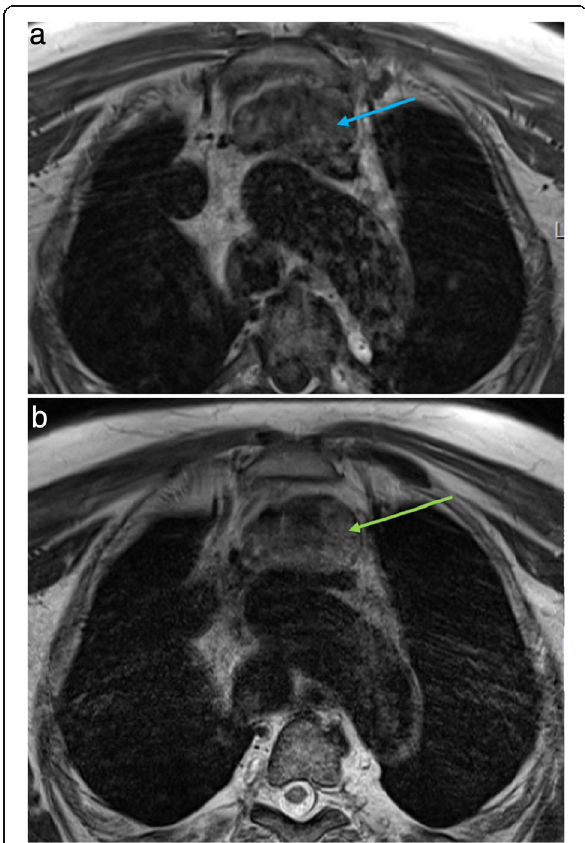
Fig. 2 Axial T1 ( a ) and T2WI ( b ) demonstrating heterogeneous anterior mediastinal mass, with well-defined margins and regular contour, with heterogeneous hypointensity signal on T1WI (blue arrow), and heterogeneous with areas of low and high signal intensity on T2WI (green arrow)